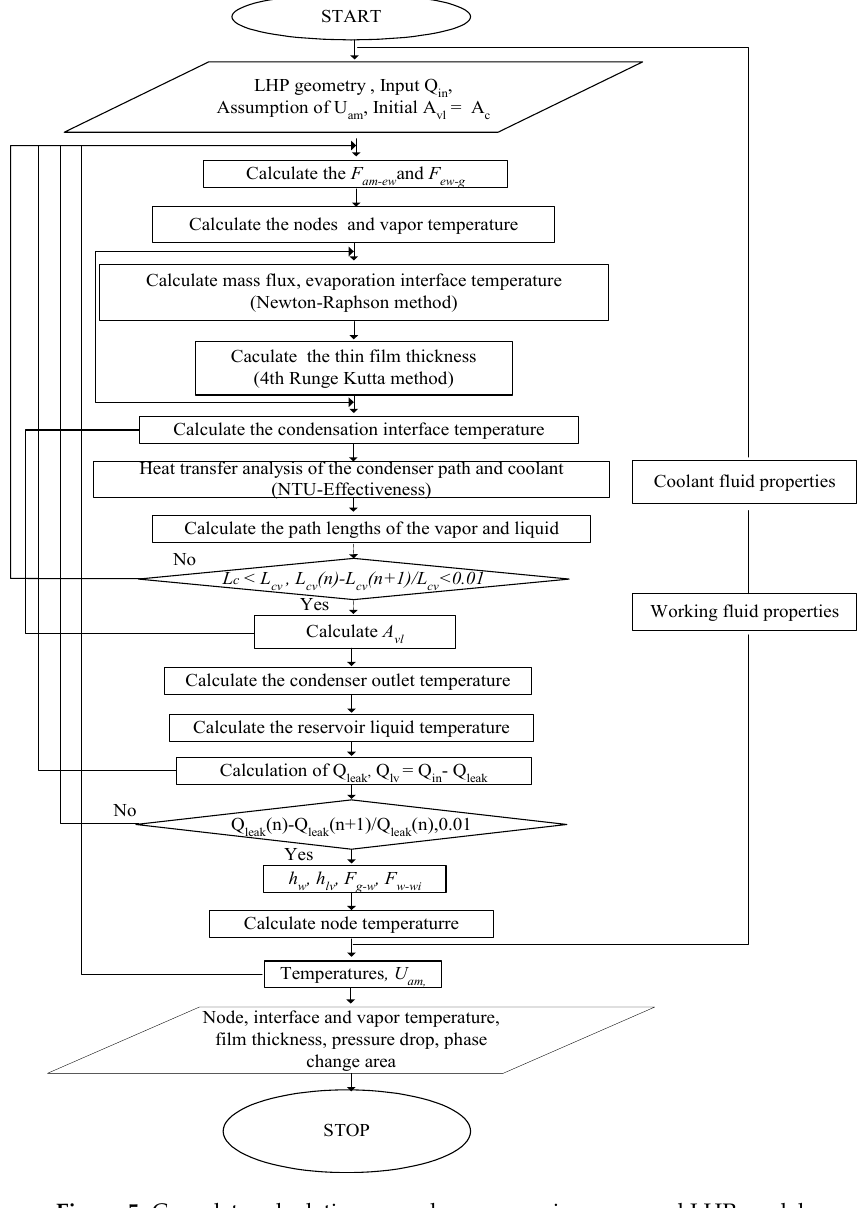
Figure 5. Complete calculation procedure concerning proposed LHP model.